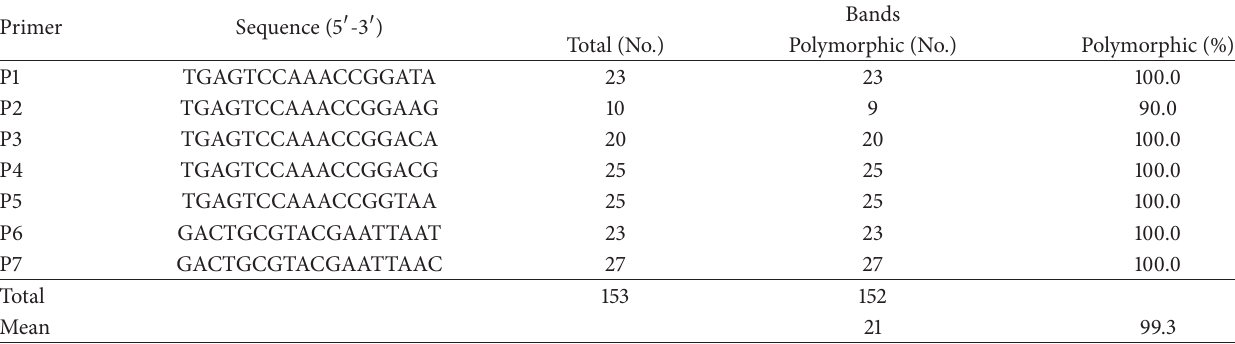
Figure 2: Dendrogram generated for the 100 S. scitamineum isolates (numbers 1–100) based on ISSR data. Table 3: List of the 7 selected SP-SRAP primers and their PCR amplification results obtained on the 100 S. scitamineum